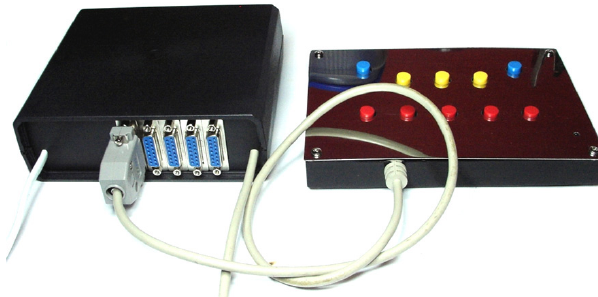
Figure 4: Button-Box (right) with interface (left).